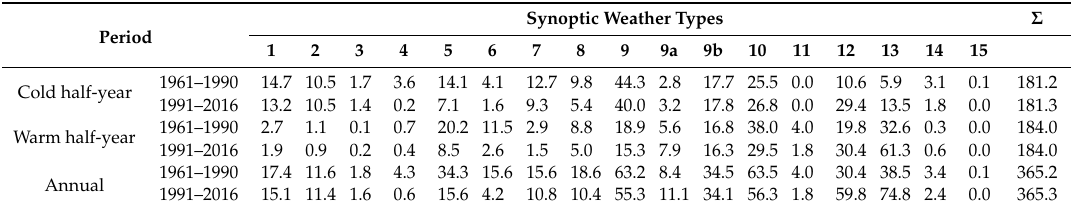
Table A4. Mean long-term duration of synoptic weather types (number of days) over Middle Asia.